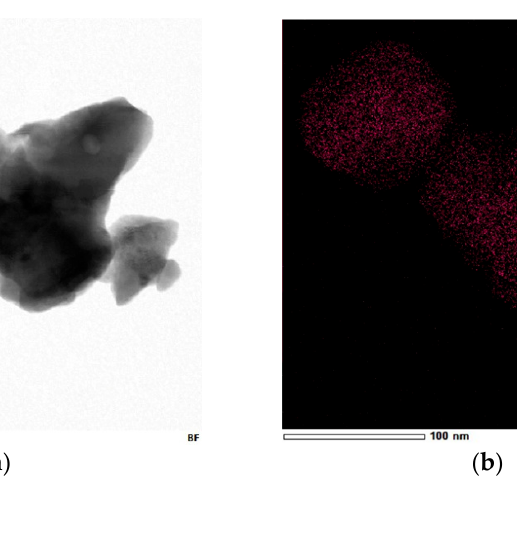
Figure 8. ( a , b ) Gd 2 O 3 :Eu 3+ nanoparticles have a homogeneous character with an average diameter of approximately 100 nm. ( c , d ) Distinct grain boundaries inside the aggregates indicate delimitation between the Gd 2 O 3 crystallites.